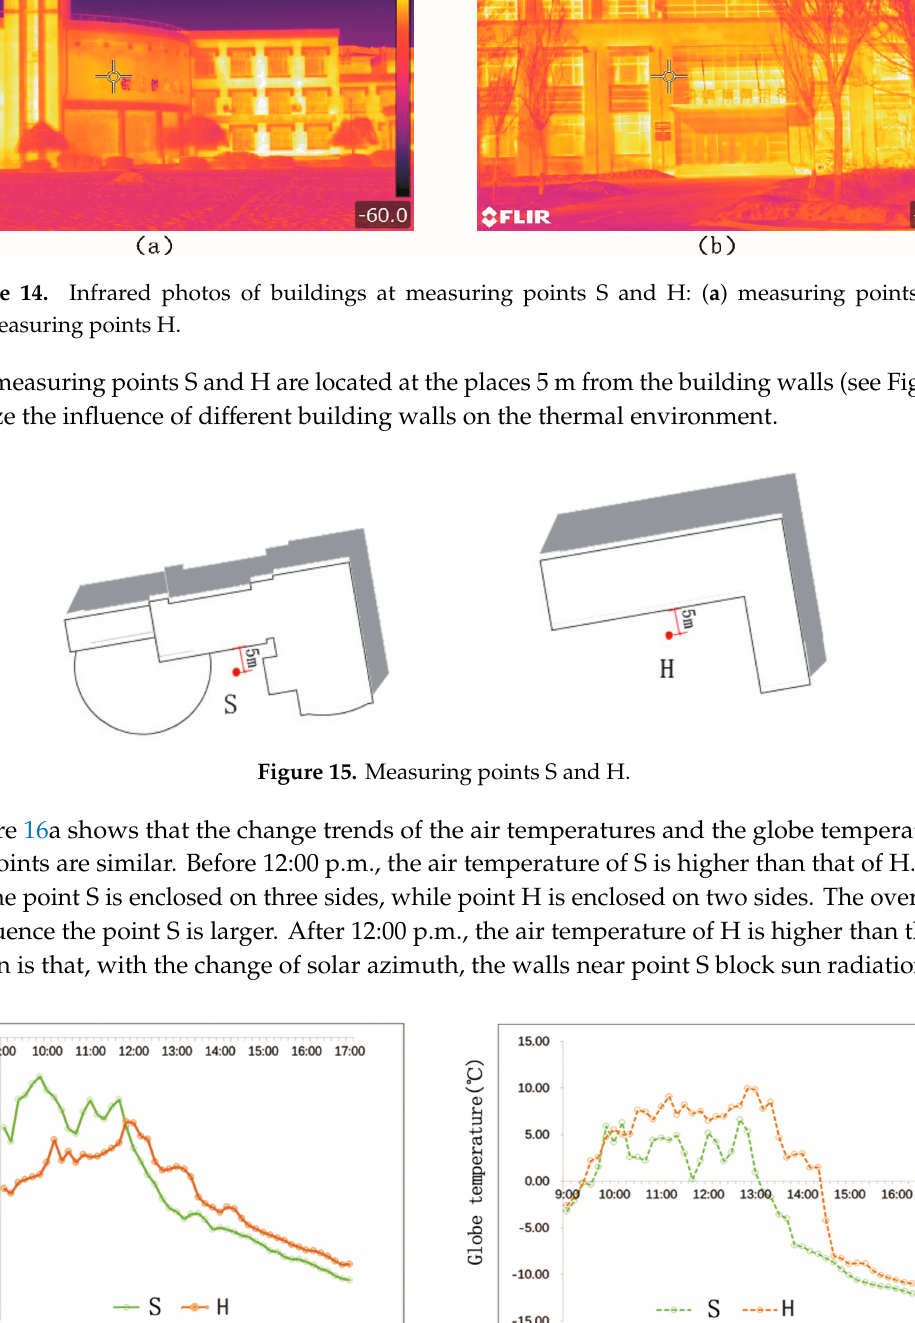
12 of 20 Figure 13. Comparison of wind speeds and wind direction frequencies on street-entry-type streets: ( a ) wind speeds; ( b ) wind direction frequencies. Figure 13b shows that the predominant wind directions of C8 and C9 are similar, but both are different from the predominant wind direction of the day. Such difference is caused by the street orientations and geometrical forms of the two measuring sites. At the east and west sides, some parts of the buildings are built on stilts. Such architectural form interacts with a chimney effect, resulting in the change of wind direction. In conclusion, wind environment is greatly affected by the spatial forms of the streets. 3.2. Influence of Building Heating Interface